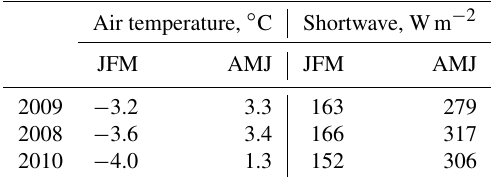
Table 2. Average (hourly) air temperature and shortwave radiation values measured at the alpine Topaz Lake meteorological station in the Tokopah Basin for JFM and AMJ of the moderately dry year (2009), near-average year (2008), and moderately wet year (2010). Air temperature, ◦ C Shortwave, Wm −